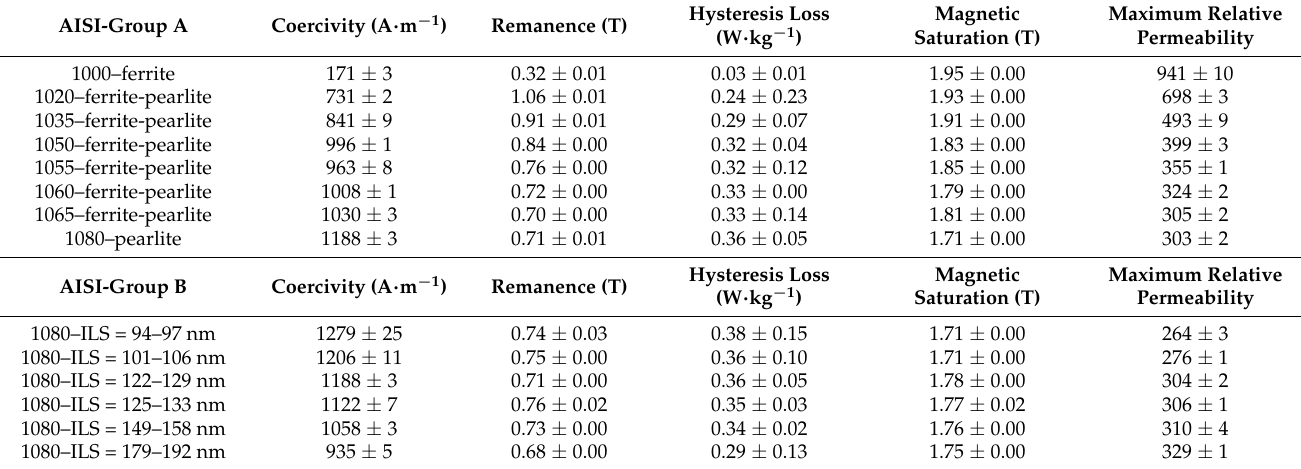
Table 4. Magnetic properties of the AISI 1000 series steels corresponding to group A and